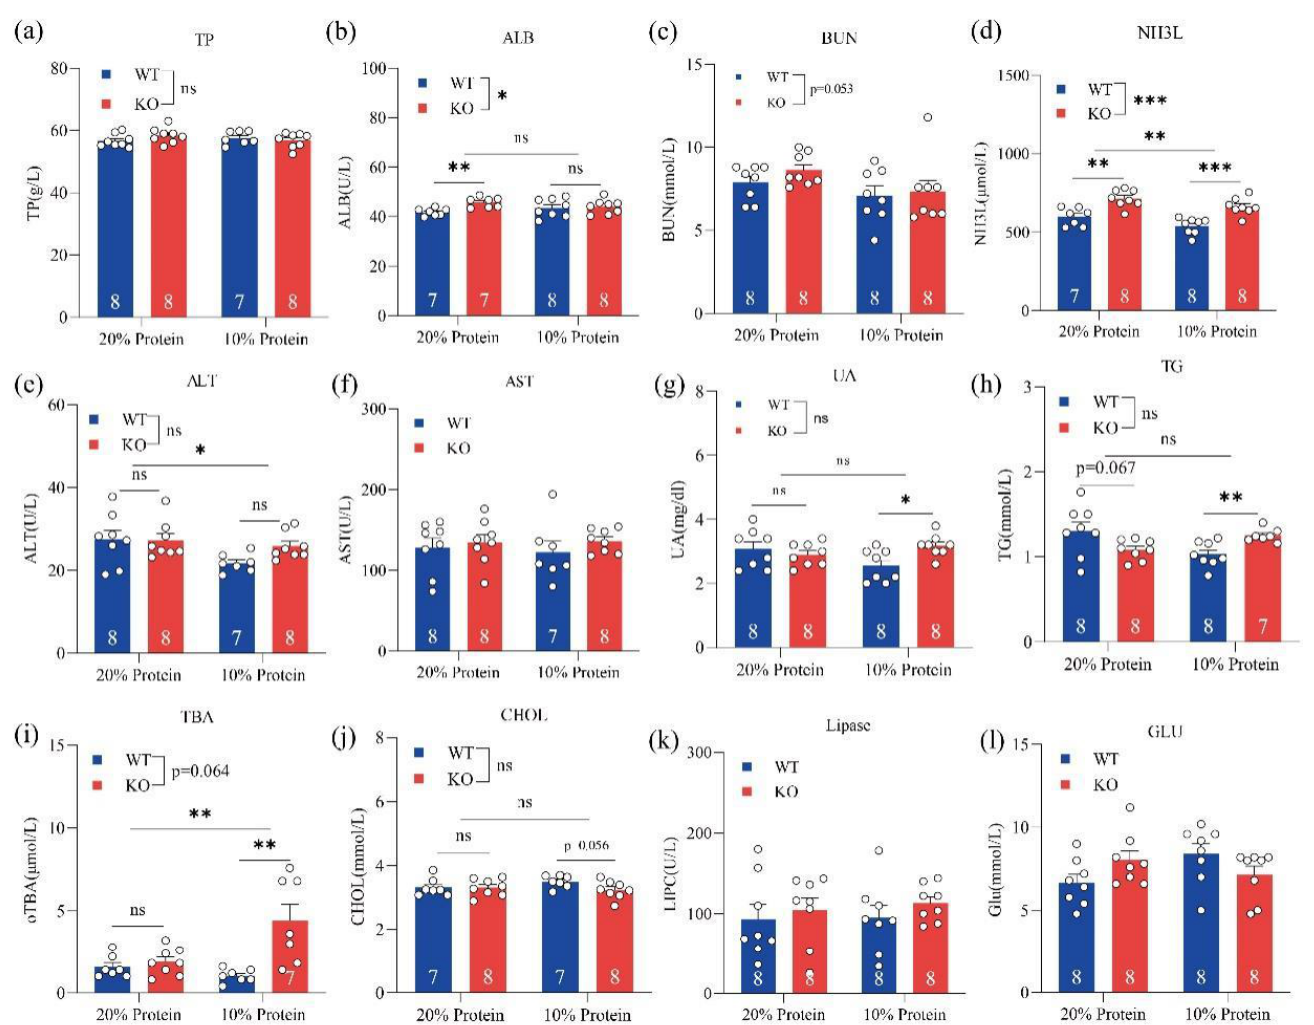
Figure 1. Effects of a GPRC6A deficiency on serum biochemical parameters in mice fed diets with different protein levels. Data are presented as means ± SE; ns represents not significant; * p < 0.05, ** p < 0.01, *** p < 0.001, n = 7 – 8. Abbreviations: TP (Total protein), ALB (Albumin), BUN (Blood urea